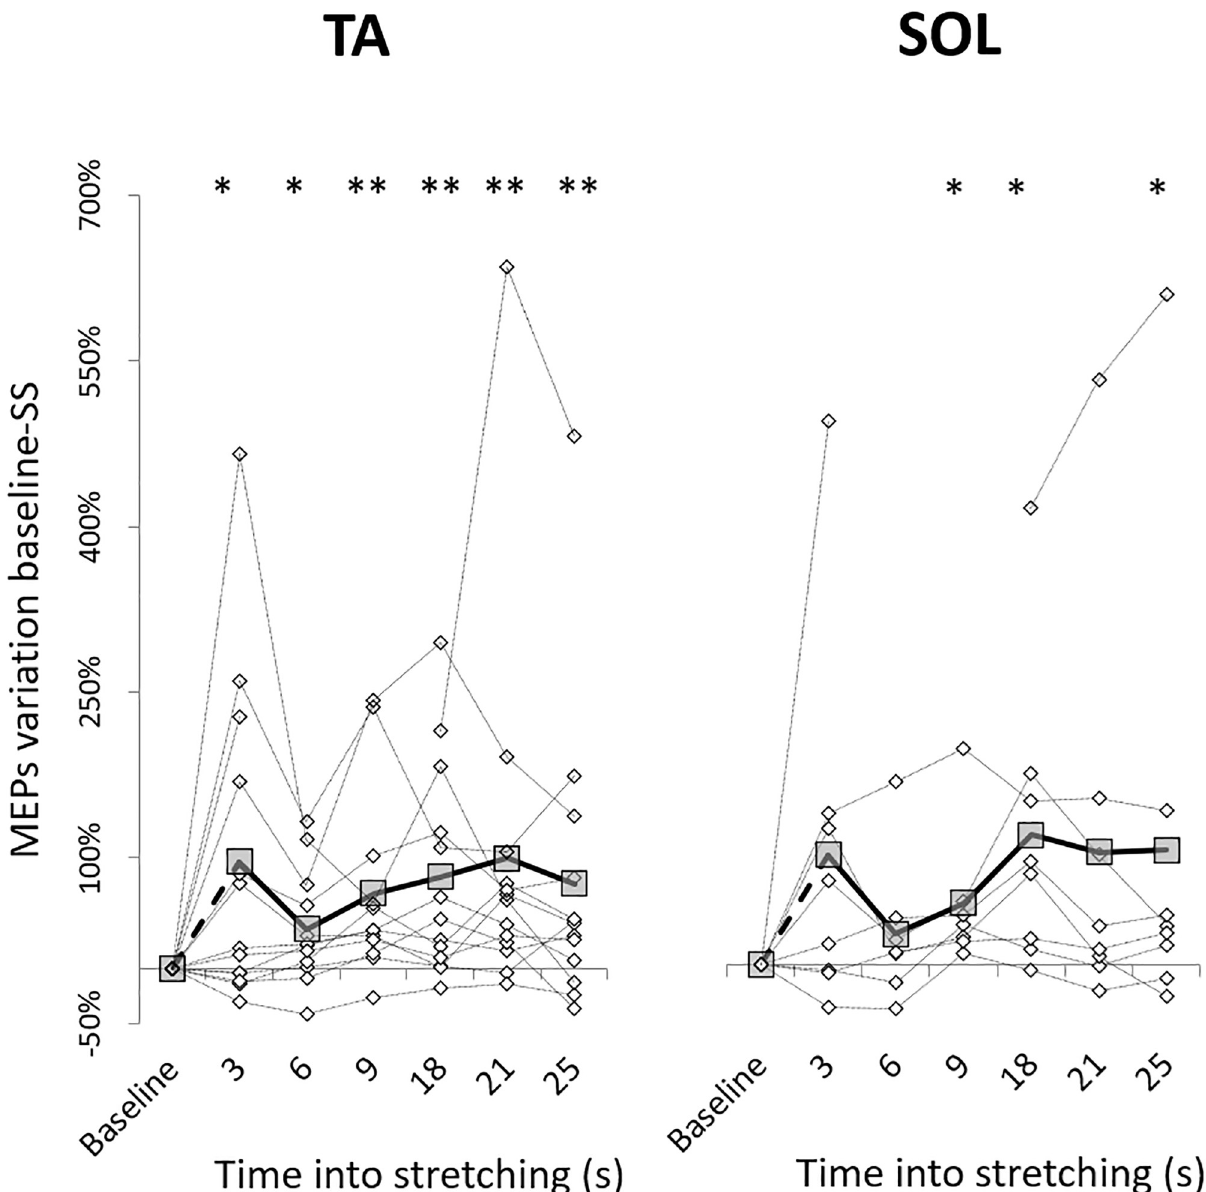
Fig 2. Time course of MEPs facilitation during stretching. Group average (thick line with squares) and individual (thin dotted line with diamonds) are expressed as percentage of variation from baseline values. Some values overlap. Comparison to Baseline: * p < .05; ** p < .01.